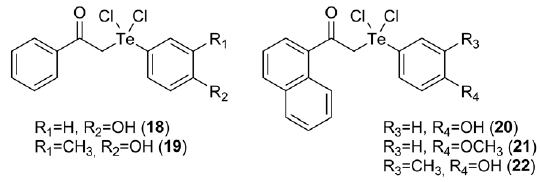
Fig. 10 – Organotelluranes with gram-negative antibacterial effect.